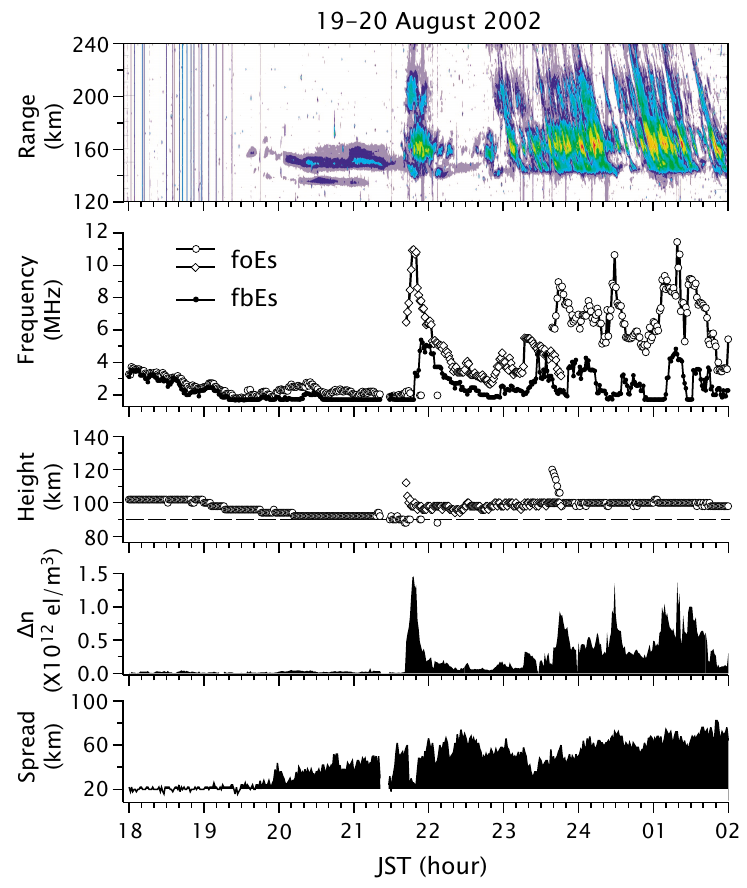
Fig. 6. Same as Fig. 3, but for the night of 19–20 August 2002. Both continuous and QP types of echoes were observed.